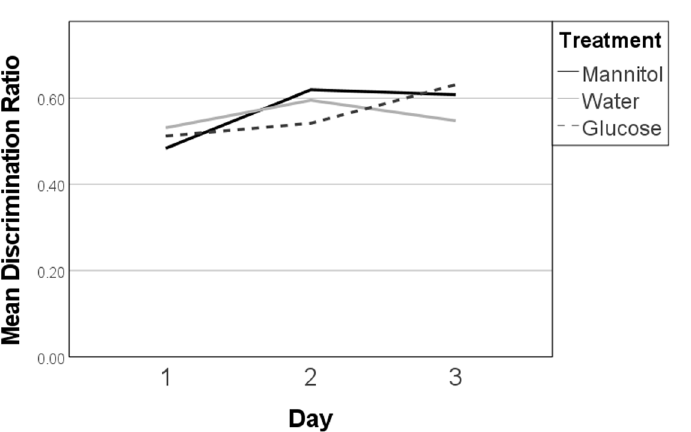
Figure 6. Discrimination ratios in the 8-week washout experiments. Discrimination ratios were calculated on all three 8-week reversal days (day 1, day 2, day 3). In this experiment, fish were exposed to hyperglycemic conditions for 4 weeks, followed by 4 weeks in normglycemic (system water) conditions. No significant differences in discrimination ratios were observed on any reversal day ( p > 0.05; one-way ANOVA). Subsequent trendline analysis also failed to identify any significant